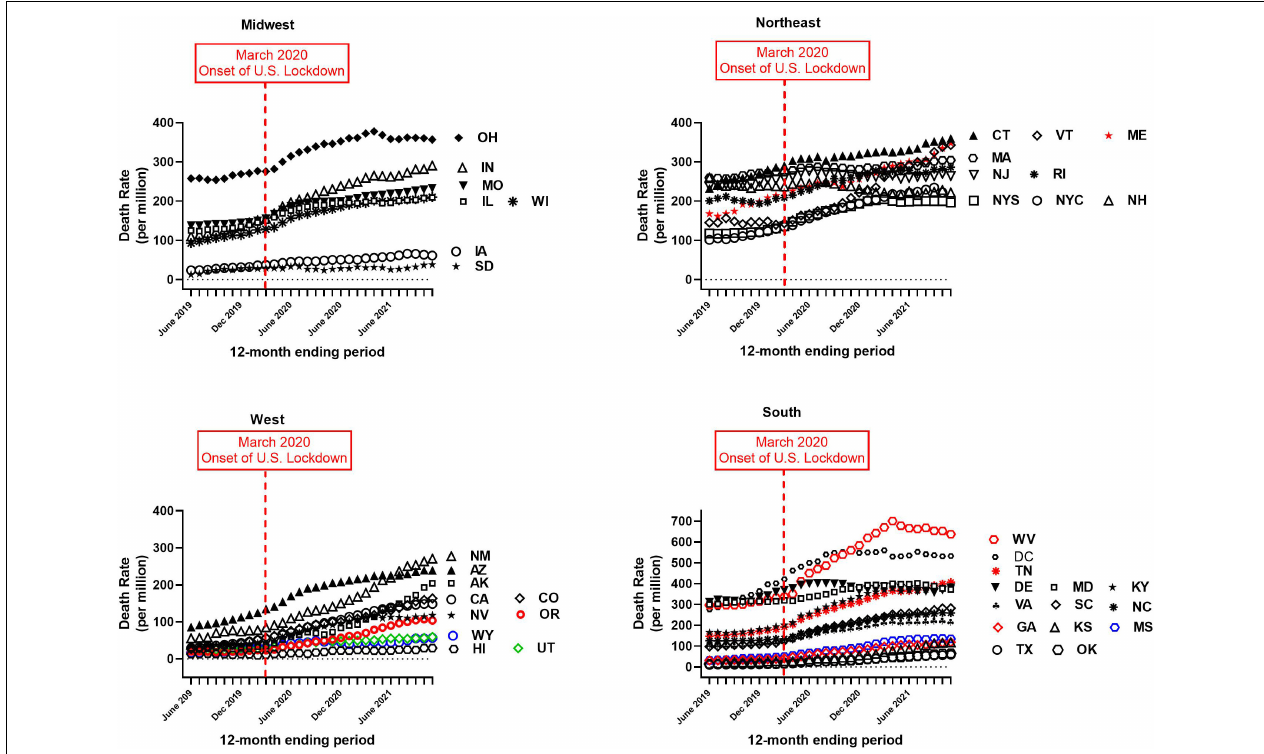
FIGURE 1 | Crude monthly mortality rate (per million), due to “synthetic opioids excluding methadone,” for June 2019–November 2021. X -axes: month; Y -axes: mortality rate (per million population). Different panels show data separated by Census region (Midwest, Northeast, West and South). Note different Y-axis scale in the panel for the South region (lower right). Labels for each authority are placed near the ending month data for each curve, to aid visualization. Abbreviations for authorities are defined in Table 1 .